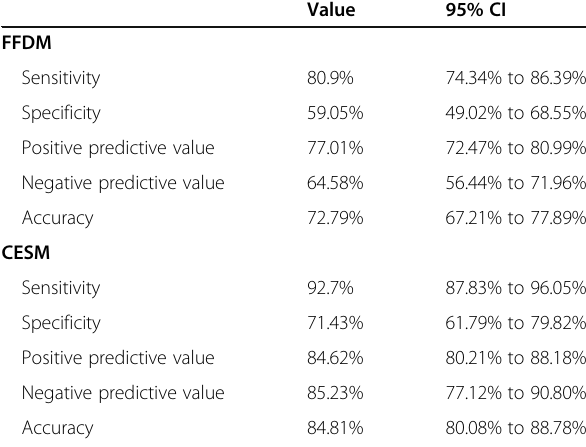
Table 5 Diagnostic indices of FFDM and